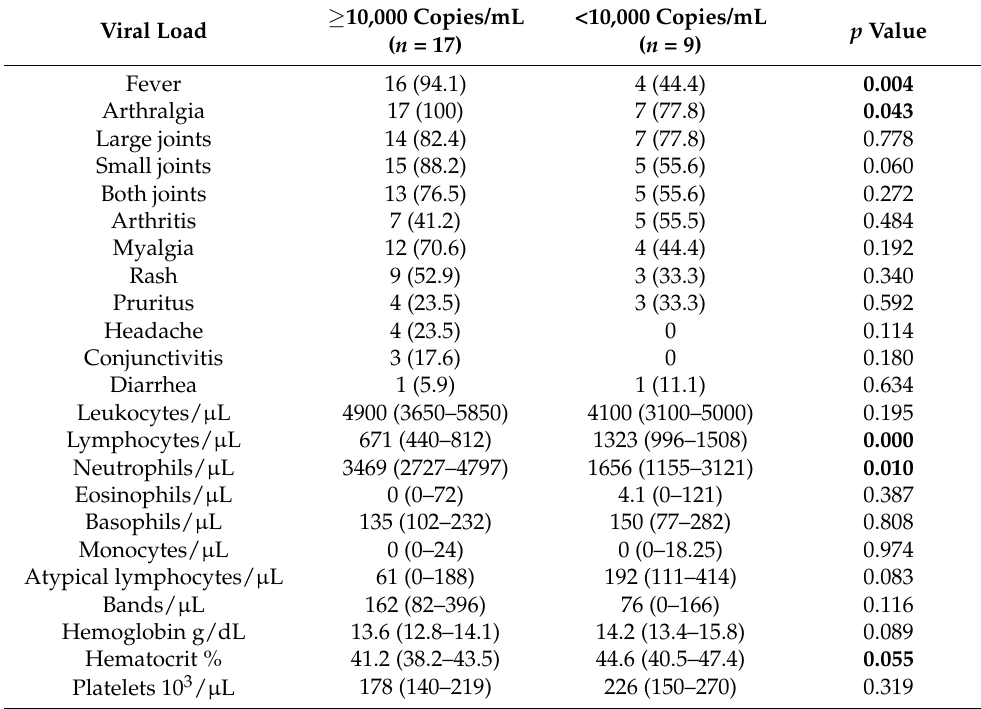
Table 2. Clinical and hematological profiles based on the level of viremia ( n =